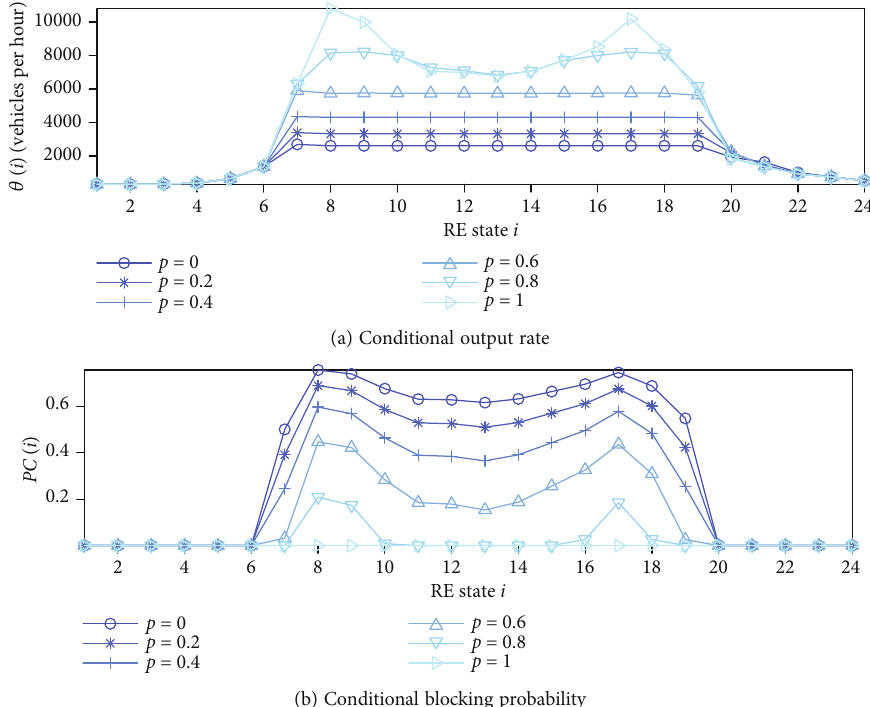
Figure 5: Varying performance measures when l = 1 mile.